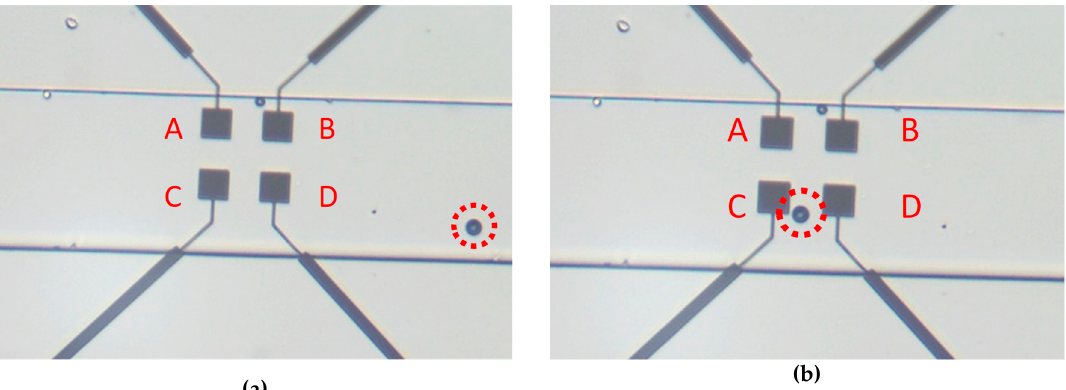
Figure 15. Microscope image of the electrodes ( a ) without the microbeads between the electrodes and ( b ) with a microbead between electrodes C and D.